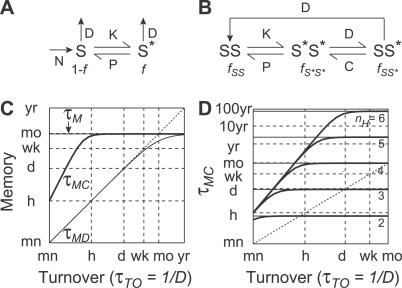
Robustness to Molecular Turnover(A) Reaction scheme of a simple extension of the aKP model incorporating molecular turnover of substrate molecules with degradation rate D (see Methods).(B) Reaction scheme of the aKP model incorporating molecular turnover and the protective mechanism proposed by Crick [51] (see Methods).(C) Memory time constant as a function of the time constant of turnover (τTO = 1/D) in the absence of turnover (τM, labeled thin line), in the presence of turnover with no protective mechanism (τMD, thin curve), and in the presence of turnover and the protective mechanism (τMC, thick curve). nH = 4.(D) Memory time constant in the absence of turnover (thin lines) and in the presence of turnover and the protective mechanism (thick curves) for different values of nH.